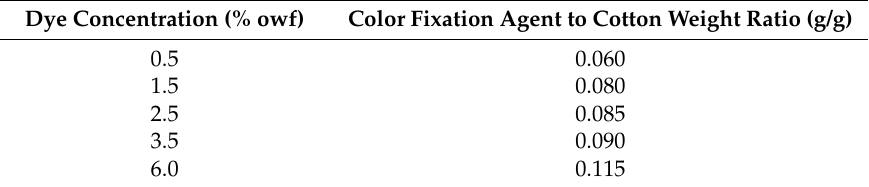
Table 2. Color fixation (soda ash) concentration used.